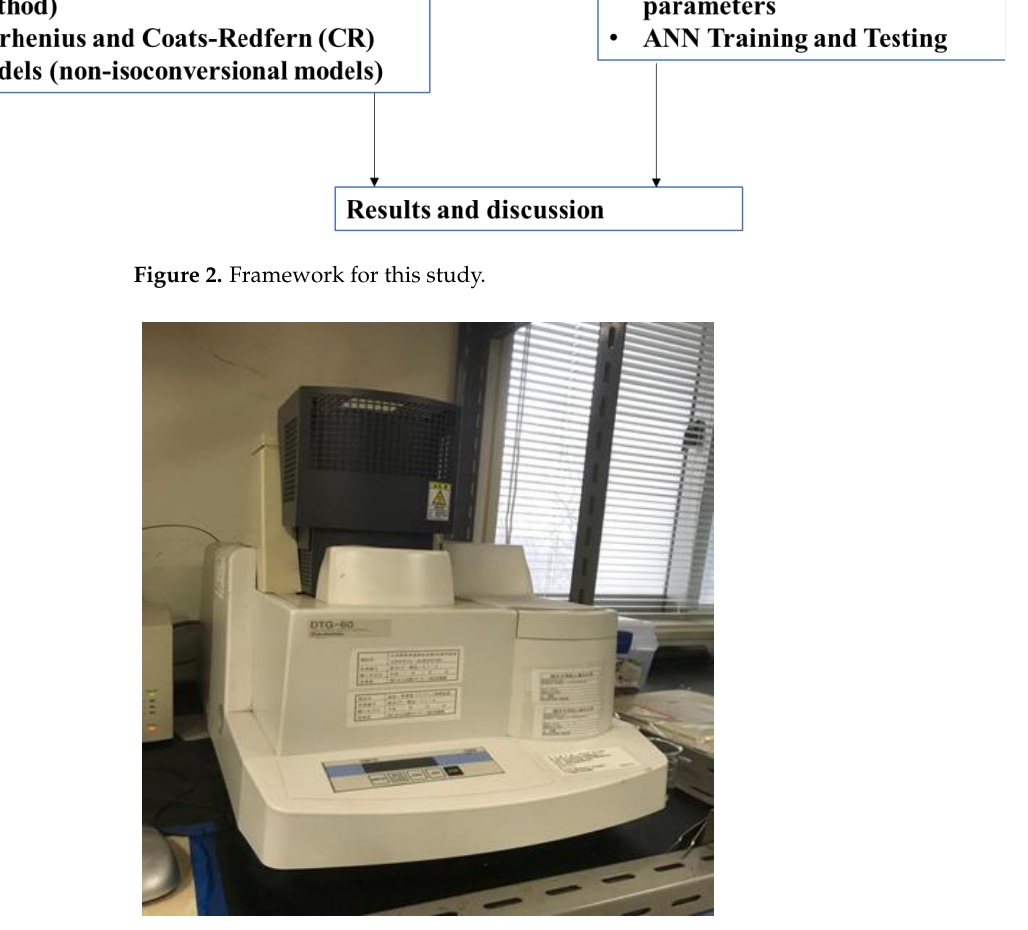
Figure 3. The TG-DTA device used in this study.